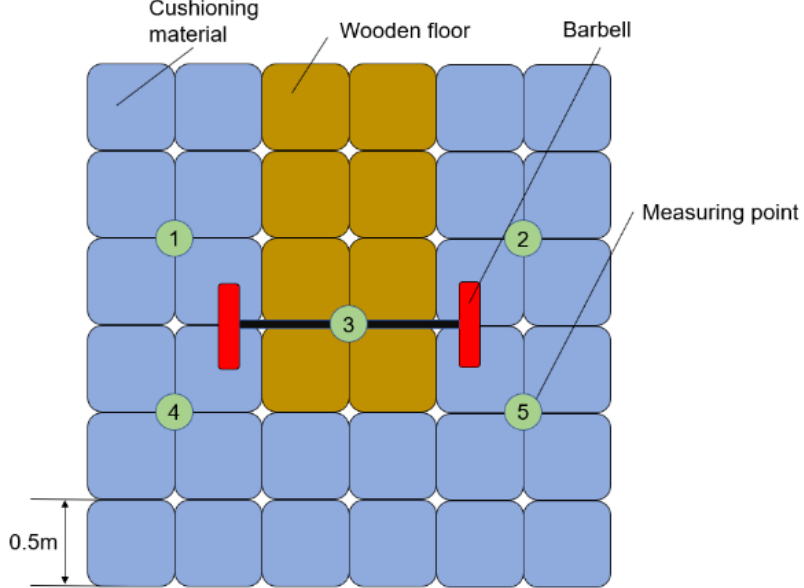
Figure 3. Arrangement of proposed test area floor. Figure 3 . Arrangement of proposed test area floor .